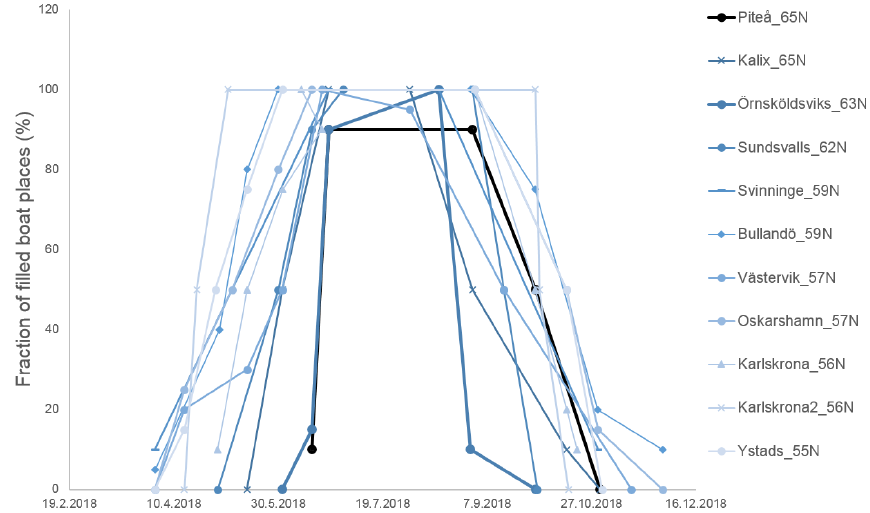
Figure 5. Seasonal patterns based on survey data for selected marinas on the Swedish coast, indicating the utilization rate of marinas as a function of